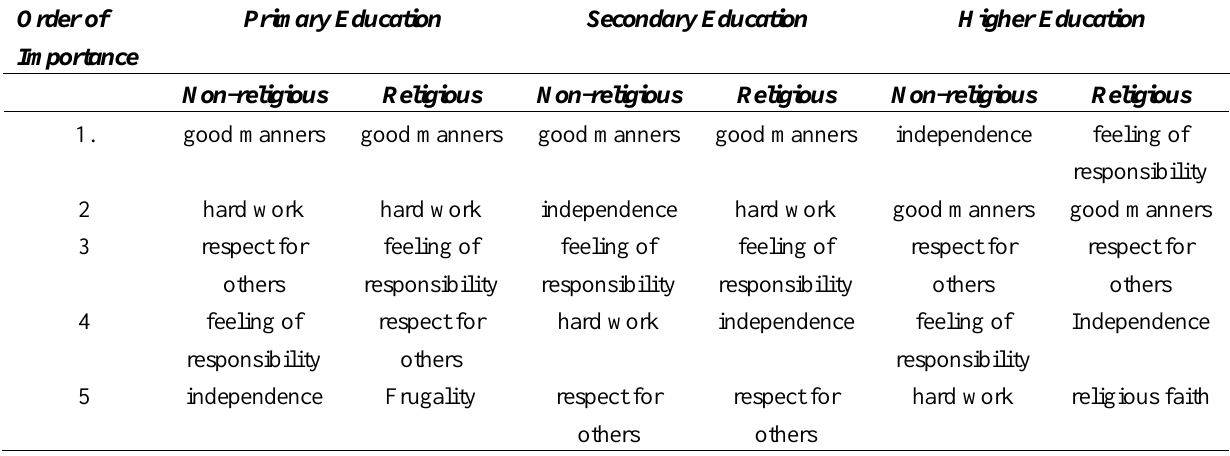
Table 1. The five most important educational values among Hungarian respondents of various school levels (2008, N =